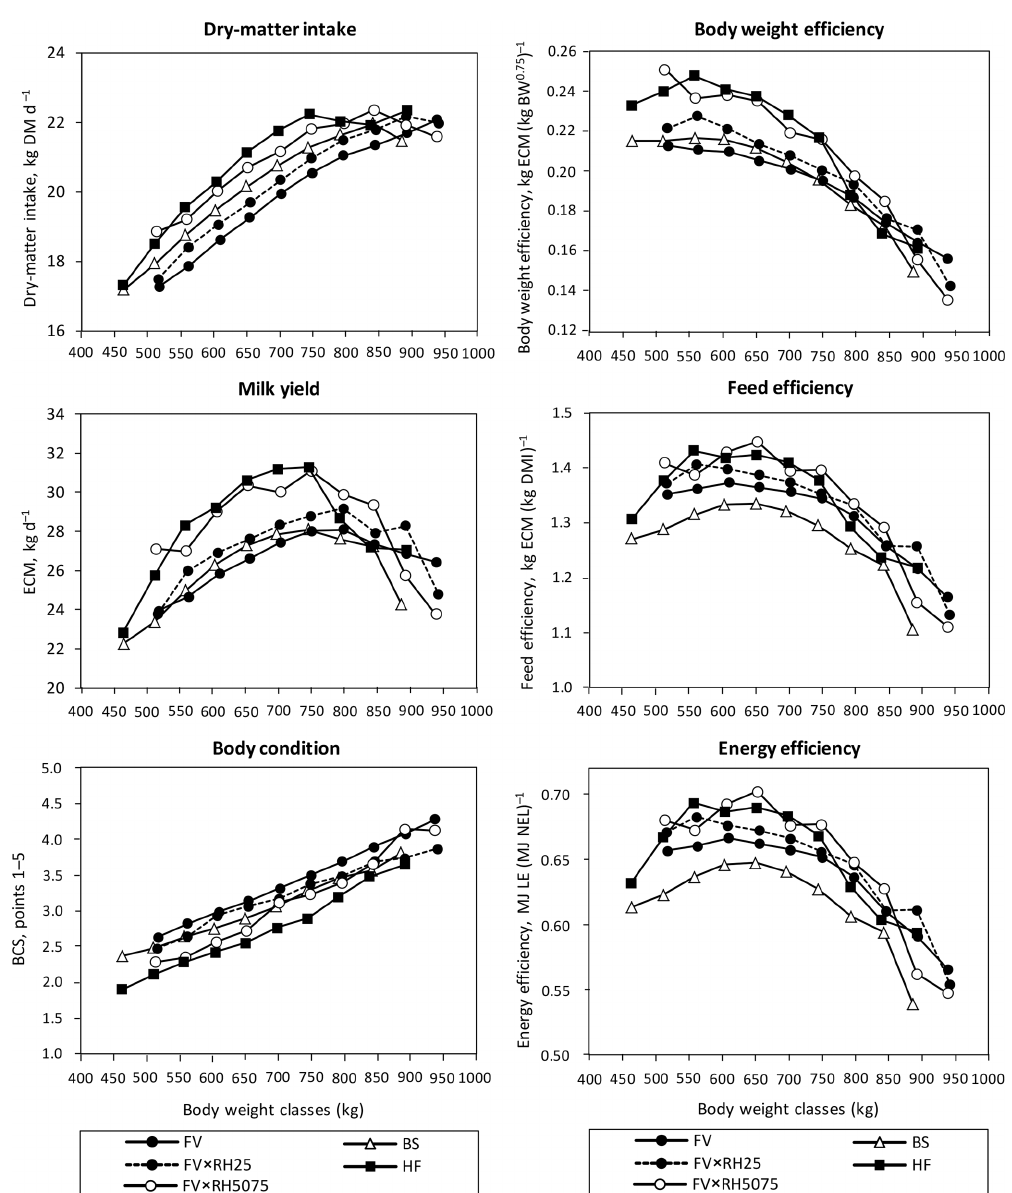
Figure 1. Effect of body weight on feed intake, milk production, BCS, body weight efficiency, feed efficiency and energy efficiency (LE: energy in milk) of Brown Swiss (BS), Fleckvieh (FV), the selected FV groups with increasing Red Holstein (RH) genes FV × RH25 and FV × RH5075 as well as Holstein Friesian